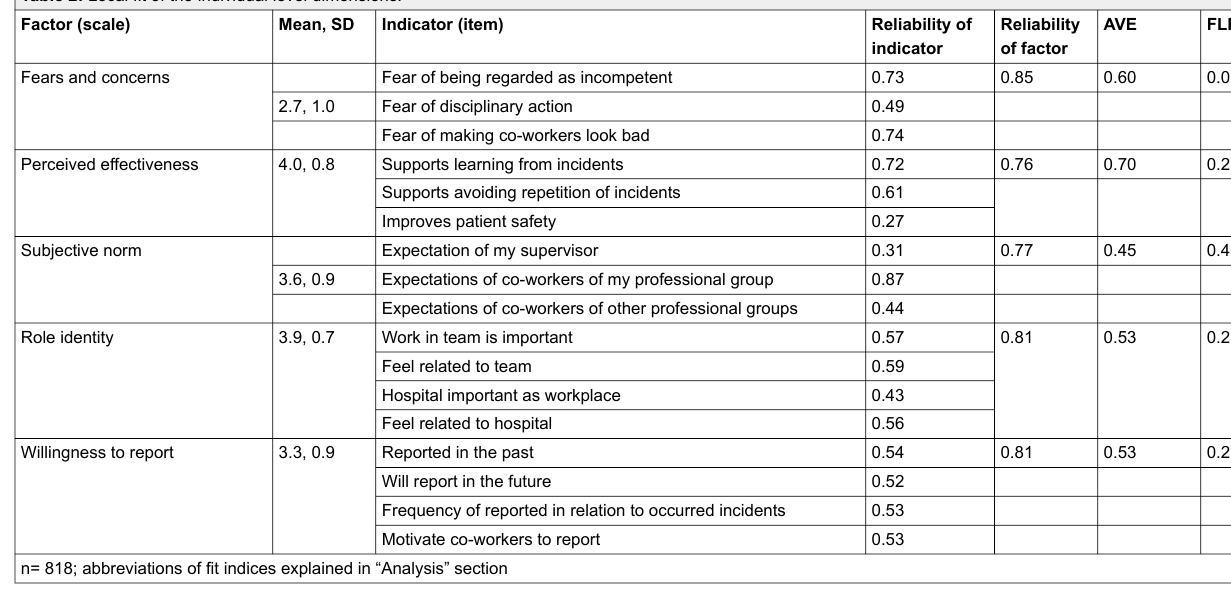
Table 3: Path coefficients and general fit indices of the structural model: individual impacts.